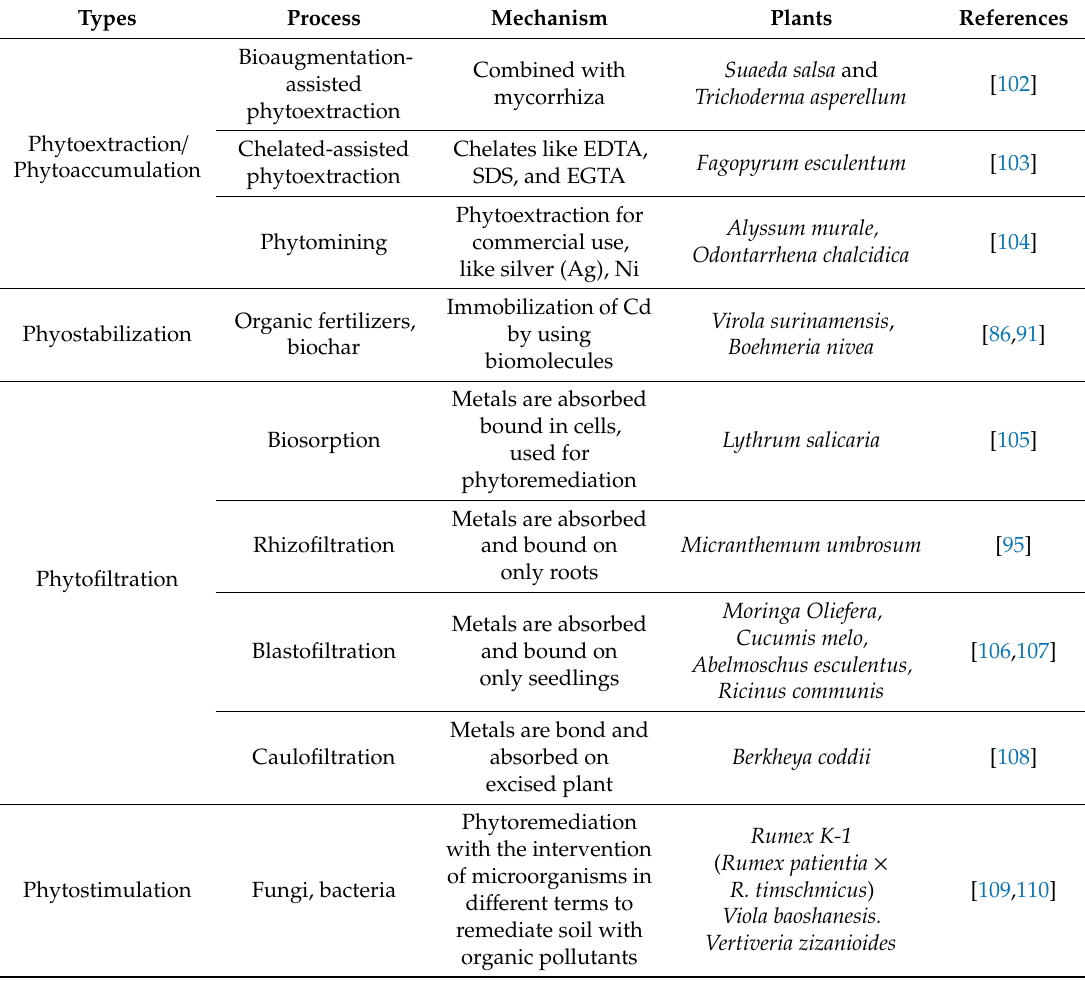
Table 1. Types of phytoremediation approaches and their specific methods. Abbreviations are explained in the